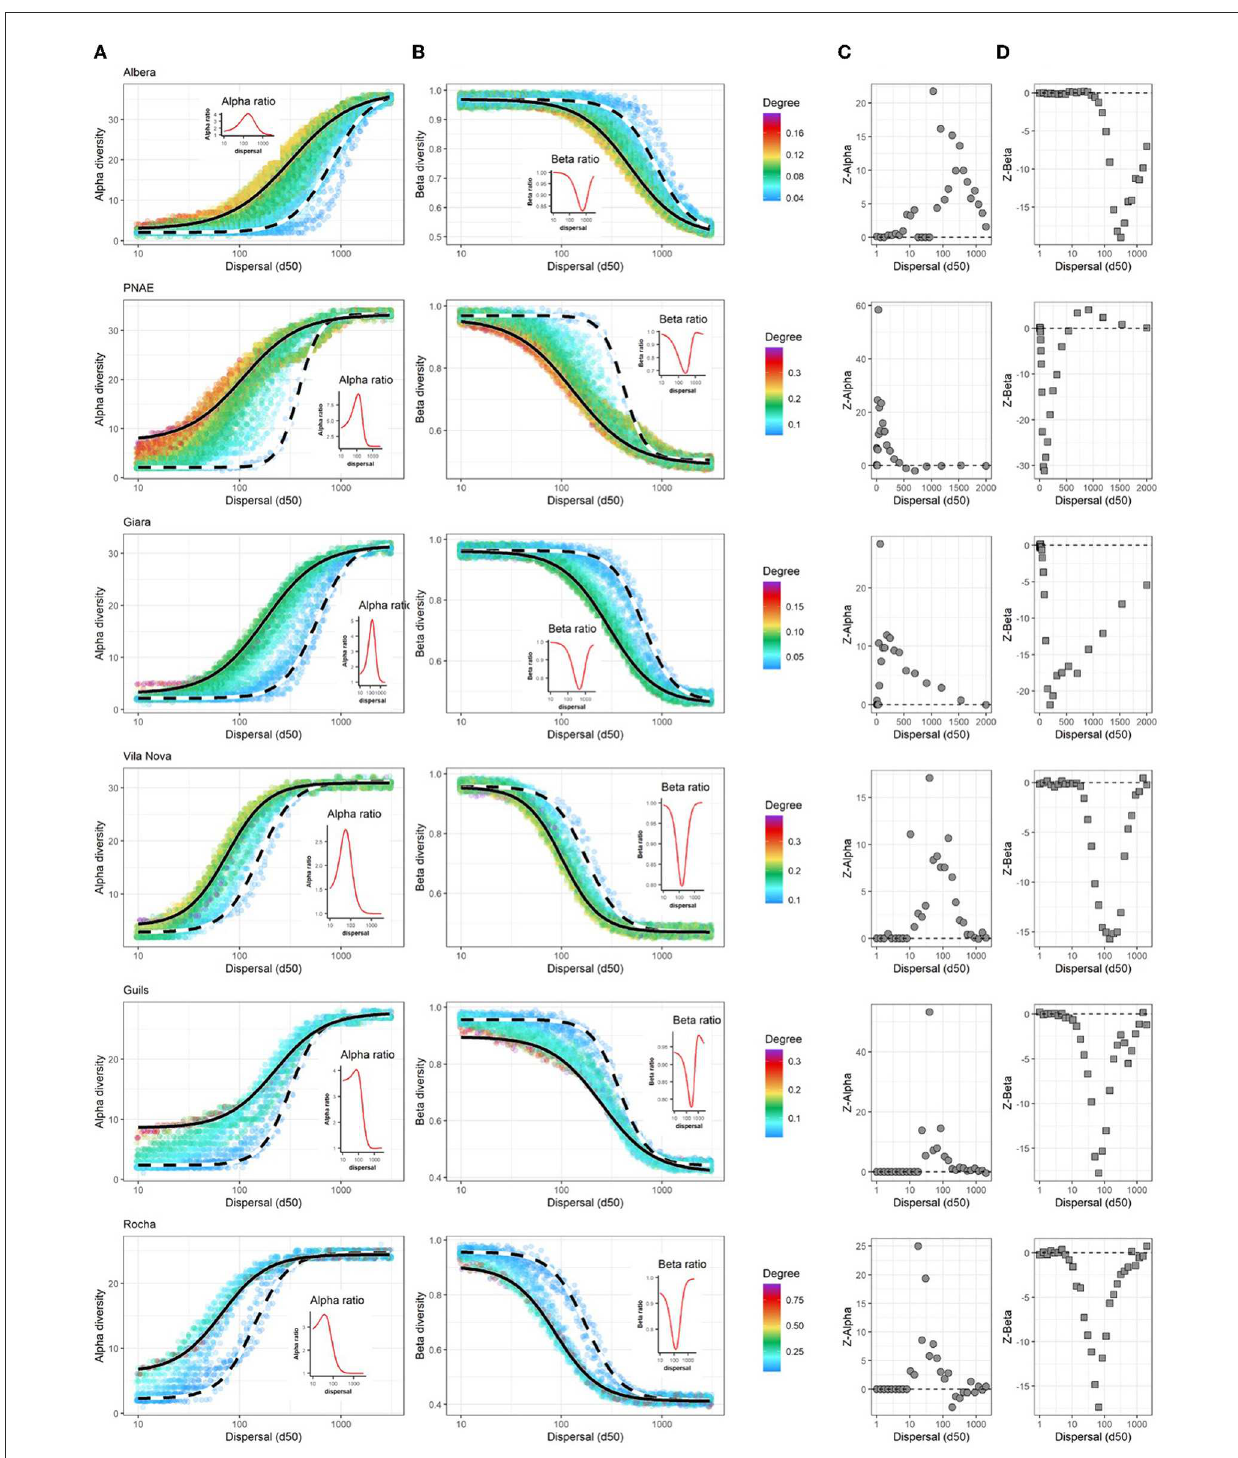
FIGURE3 Interplay between the spatial arrangement of waterbodies and species dispersal ability as determinants of metacommunity biodiversity. Rows correspond to metacommunities of waterbodies. (A, B) Alpha and beta diversities along a dispersal ability gradient. Dispersal ability in x-axes is the distance at which dispersal falls to half of its maximum rate ( d 50 ). The colors of points represent the isolation-centrality gradient (weighted degree centrality) of communities. A jitter was applied to better visualize the range of waterbody isolations. The black curves represent the set of more isolated (dashed) and central (continuous) communities in the pondscape. The inset figure is the ratio for alpha or beta diversity in the most peripheral vs. the most central community in the gradient of dispersal ability—i.e., Ratio alpha and Ratio beta . (C, D) Importance of the spatial arrangement of ponds for alpha and beta diversities along the gradient of dispersal abilities. Z − values correspond to standardized deviations of diversity predicted for the real pondscape structure ( S obs ) and the average diversity expected by the null model prediction when the location of , for each dispersal ability ( d 50 communities was randomized ( S null ): Z − value = ( S obs − S null ) SD ( S null )